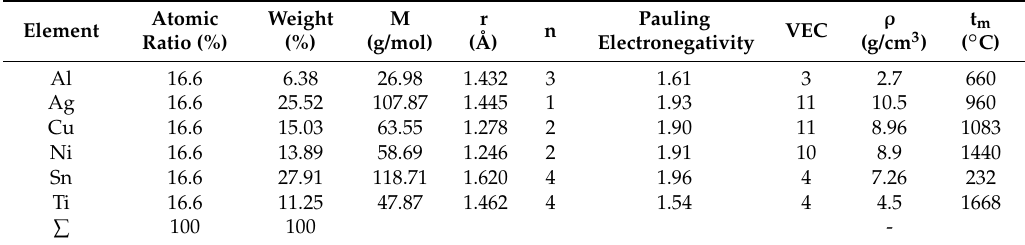
Table 1. Some physical data and the proportion of chemical elements that form the AlAgCuNiSnTi alloy.